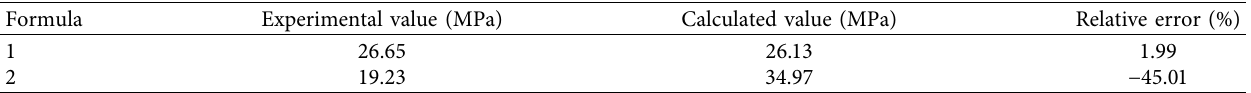
Table 3: Comparison of experimental and calculated values of the first incident shock wave peak pressure.